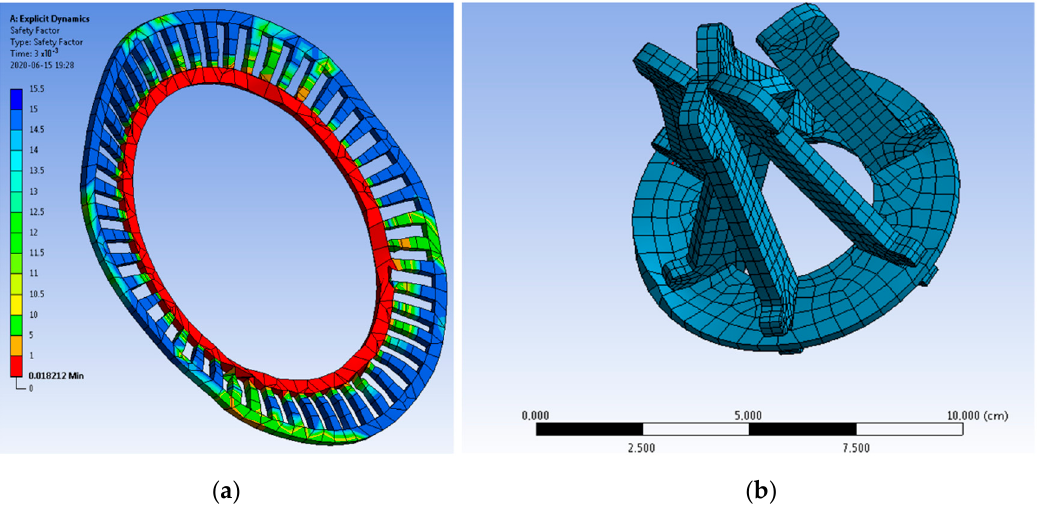
Figure 22. Deformation of the crowns: ( a ) Outer crown and ( b ) inner crown.